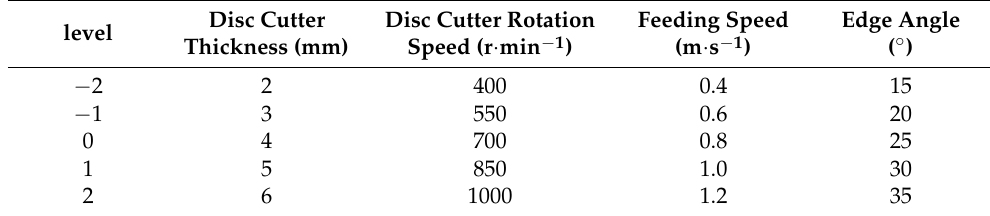
Table 3. Test factors and